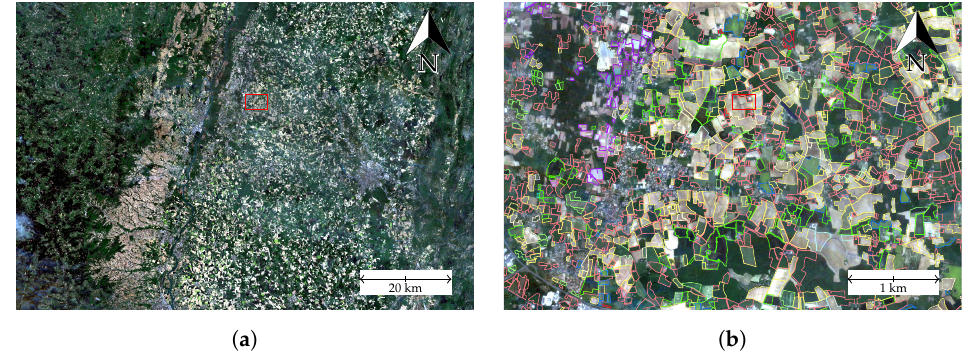
Figure 2. Area of Interest. The studied parcels are taken from the 31TFM Sentinel-2 tile, covering an area of 110 110 km and containing over 103,602 parcels meeting our size, shape, and stability criteria. × ( a ) Large view of the tile. ( b ) Detail of the area.